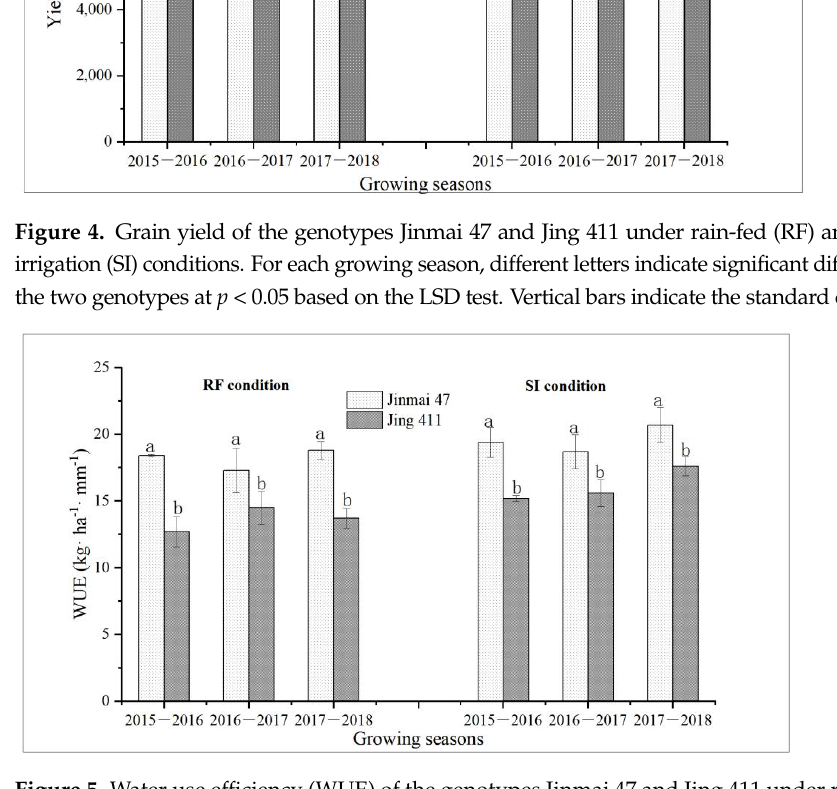
Figure 5. Water use efficiency (WUE) of the genotypes Jinmai 47 and Jing 411 under rain-fed (RF) and supplemental irrigation (SI) conditions. For each growing season, different letters indicate significant differences between the two genotypes at p < 0.05 based on the LSD test. Vertical bars indicate the standard deviation.